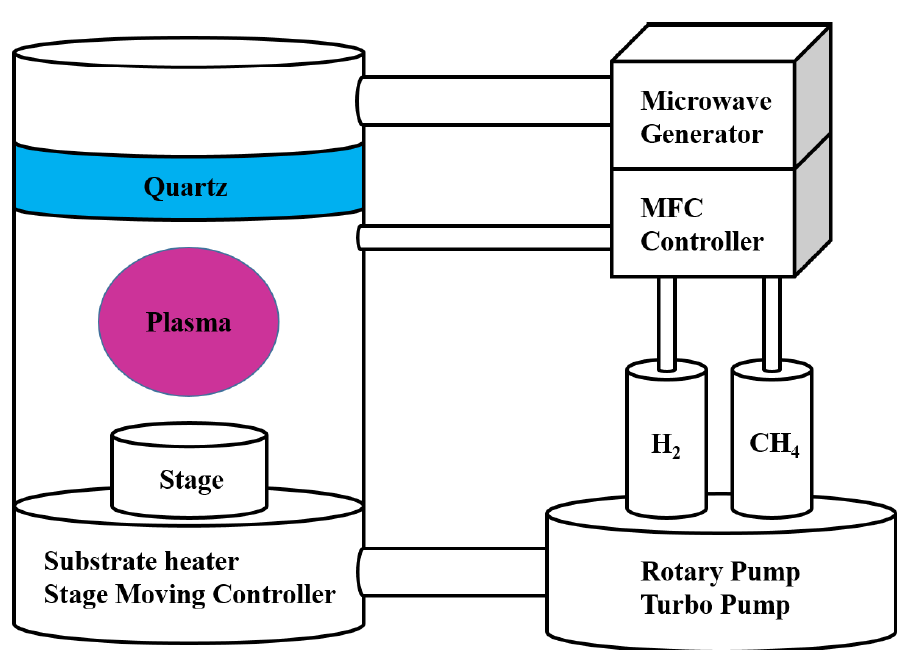
Figure 2. The schematic diagram of PECVD.